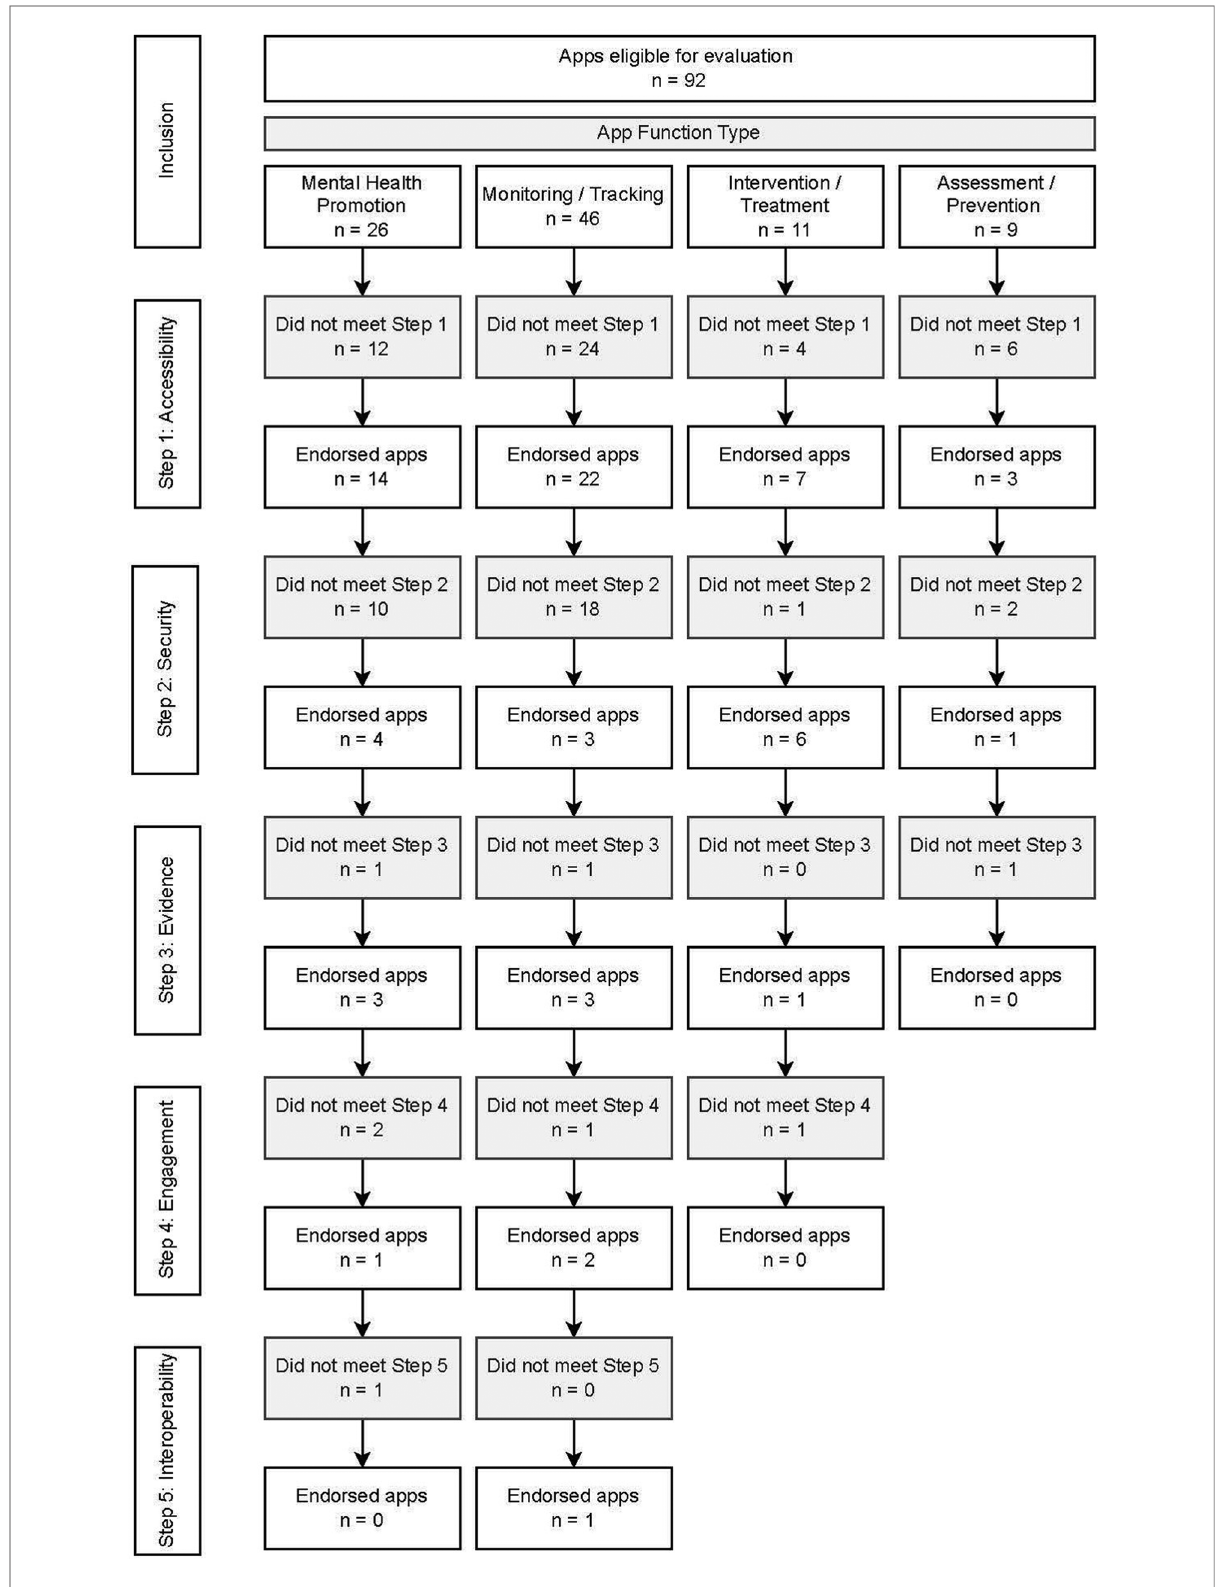
FIGURE 5 Quality assessment of 92 apps grouped by their function